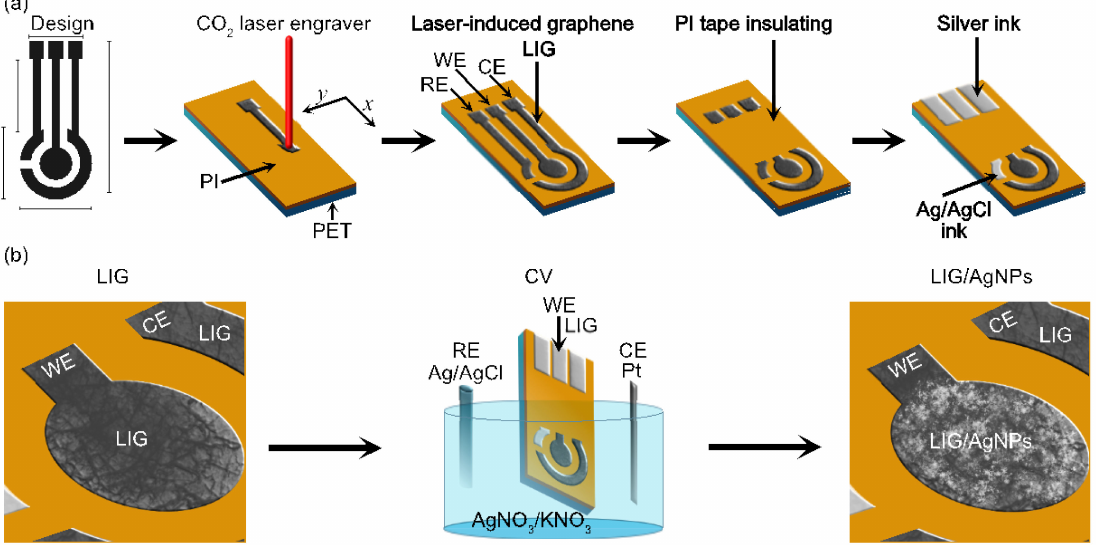
Figure 1. Schematic representation of LIG/AgNPs sensor fabrication: ( a ) laser-induction procedure with DC-KIII CO2; ( b ) electrodeposition of AgNPs on the working electrode